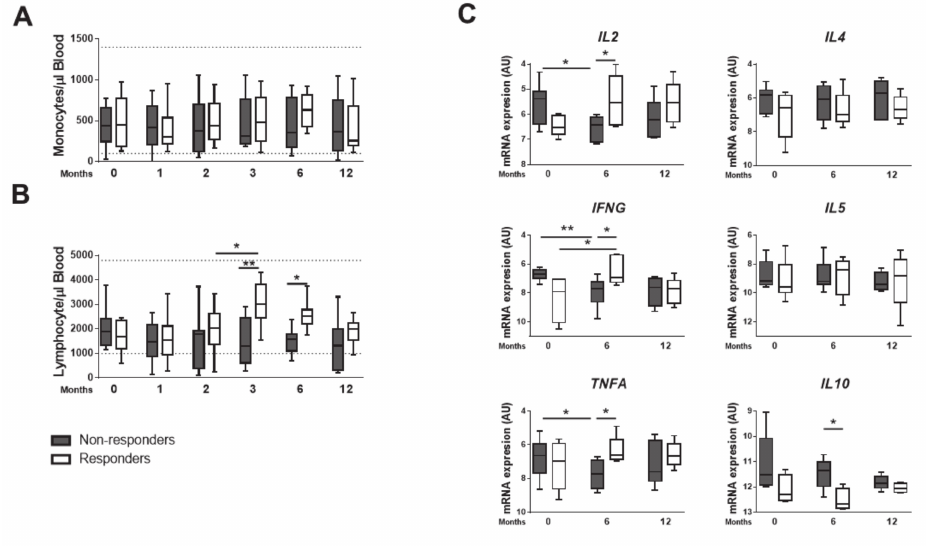
Figure 2. Responder dogs display Th1 signature. The serum absolute numbers of monocytes ( A ) and lymphocytes ( B ) was quantified from T0 until 12 months post treatment. mRNA was isolated from spleen biopsies at T0, T6 and T12. Quantitative PCR was performed for IFNG , TNFA , IL2 , IL4 , IL5 and IL10 ( C ). Data are shown as mean ± SD or in a box and whisker plot format, Responder dogs ( n = 9) Non responder dogs ( n = 8) * p < 0.05; ** p <